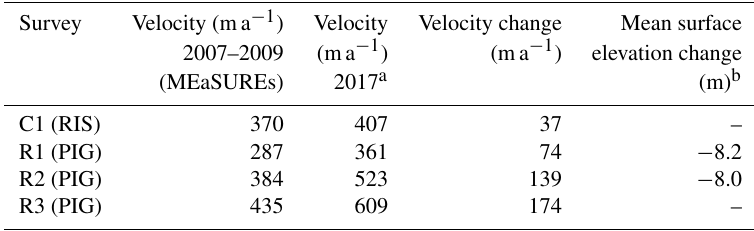
Table 1. Mean velocities and surface elevation change for each repeat radar survey profile 2007–2017.